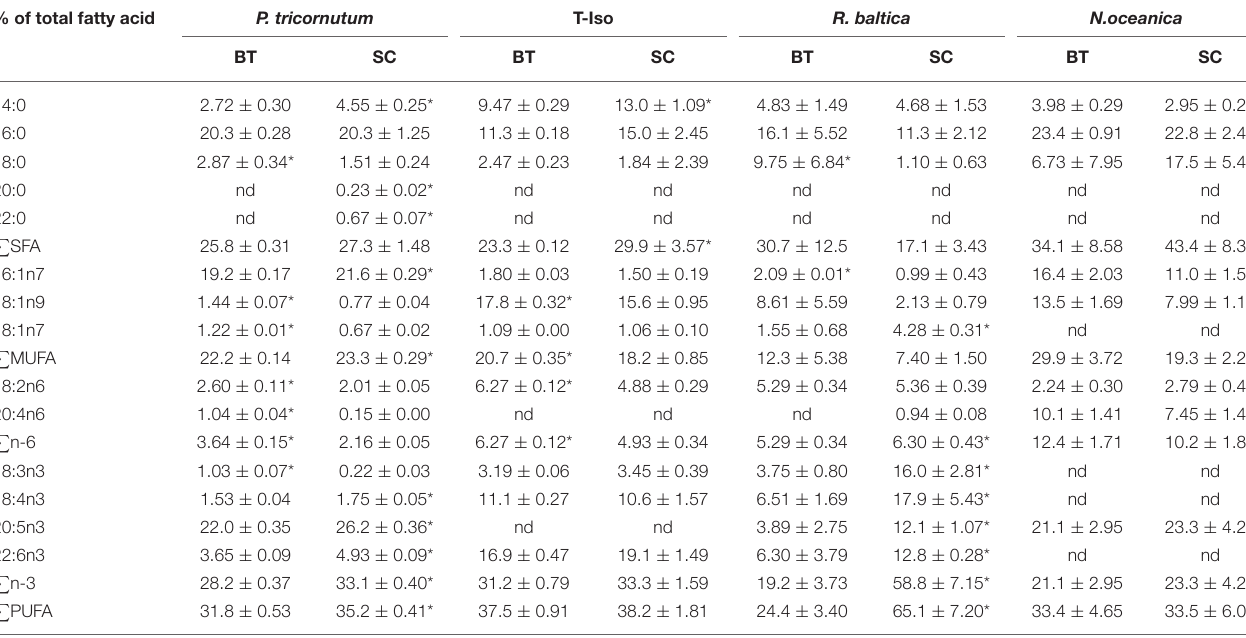
TABLE 4 | Fatty acid profiles in polar lipid (PL) of four microalgae species cultured under nitrogen limitation, by batch (BT) and semi-continuous culture (SC). % of total fatty acid P. tricornutum T-Iso